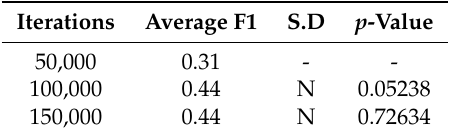
Table 7. Zeus Dataset—Training Iteration